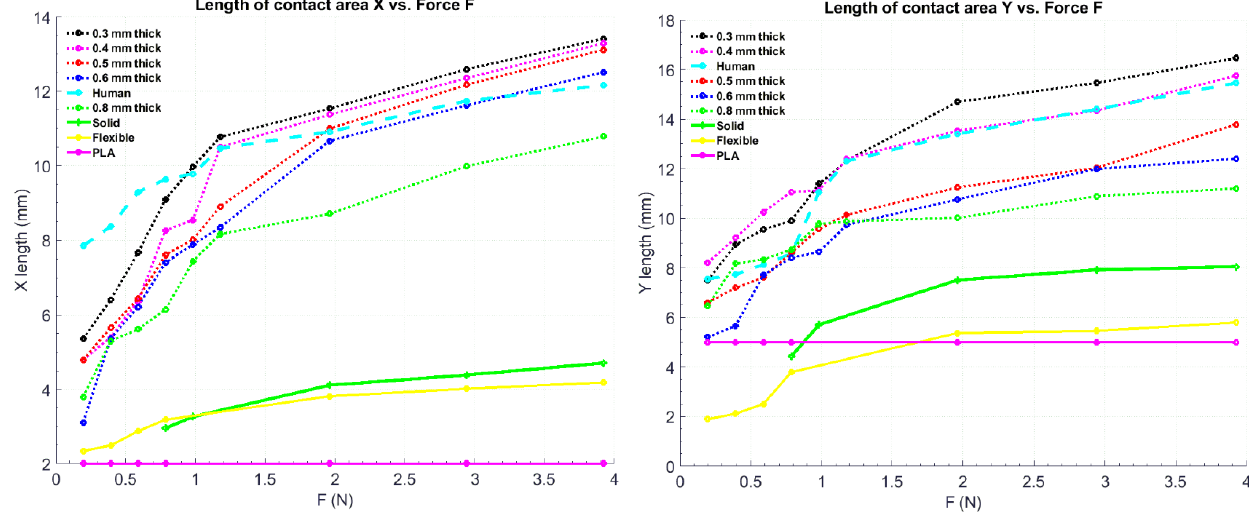
Figure 4. Graphical representation of the deformation of Formlab TM elastic 50 A material under pressure [33].